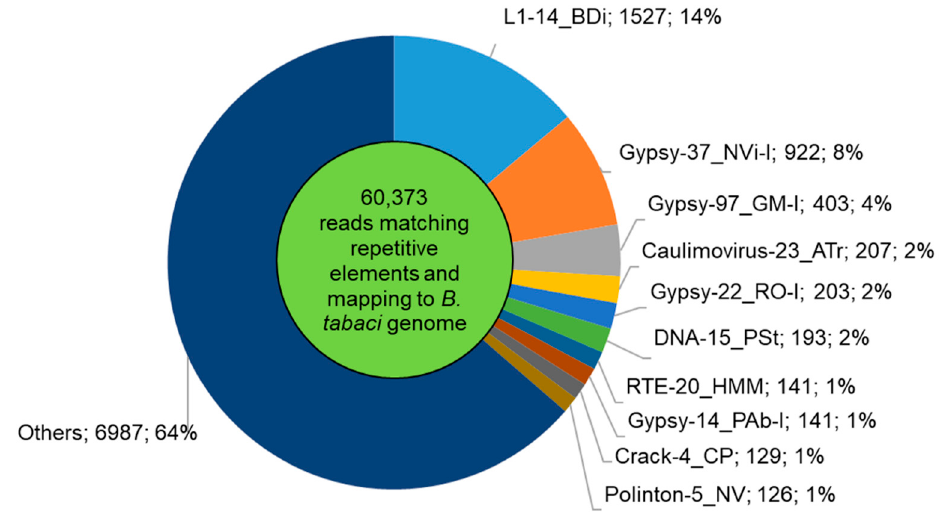
Figure 4. Features of small RNAs of Aleurocanthus spiniferus and their abundance in the library: Insects 2020 , 11 , x FOR PEER REVIEW sequencing reads of the entire library ( A ) and those mapping to Bemisia tabaci genome ( B ).